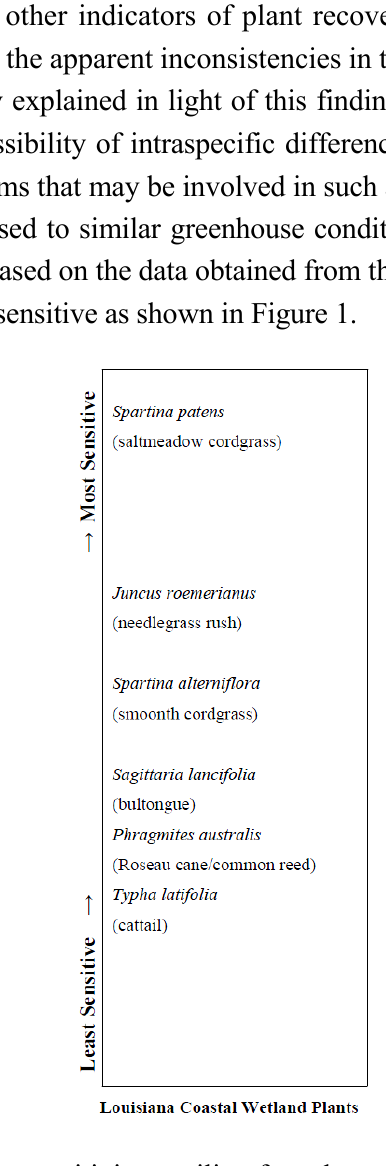
Figure 1. Ranking of relative sensitivity to oiling for selected Louisiana Coastal Marsh